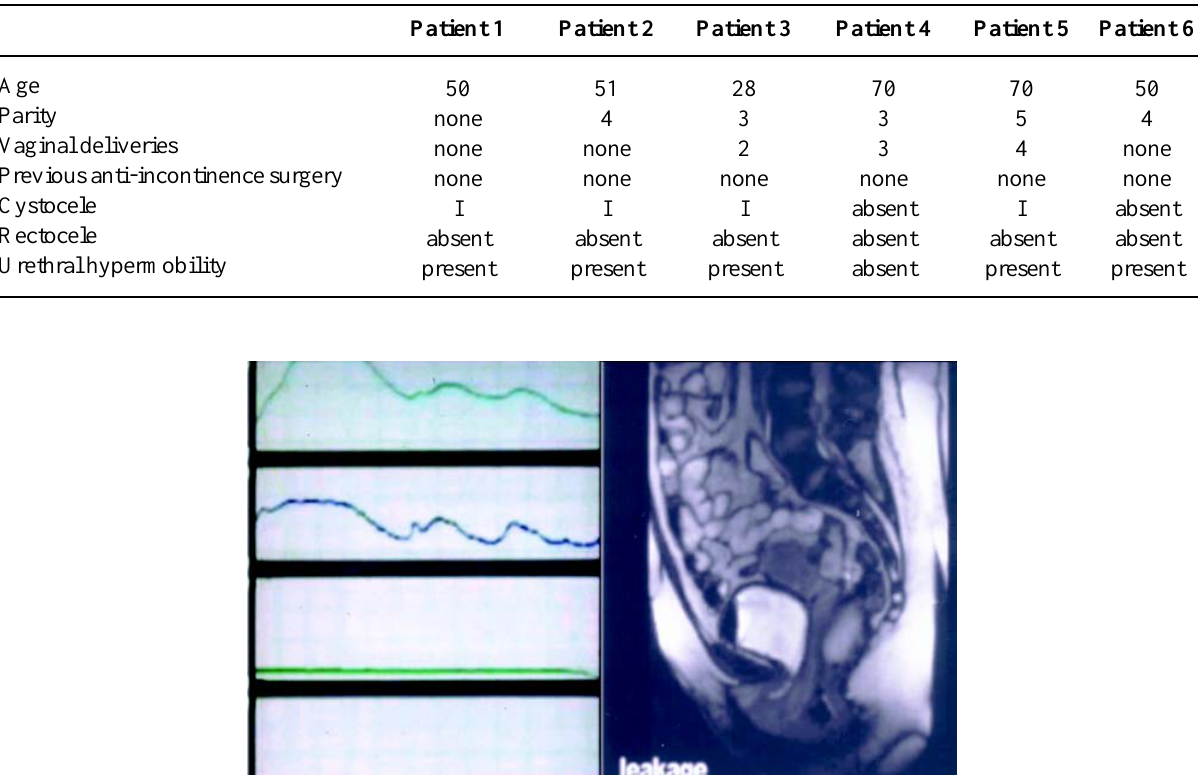
Figure 1 – Magnetic resonance imaging video urodynamics. Synchronous display of urodynamic parameters and sagittal magnetic resonance image of the pelvis. Table 1 – Patient’s history and physical examination